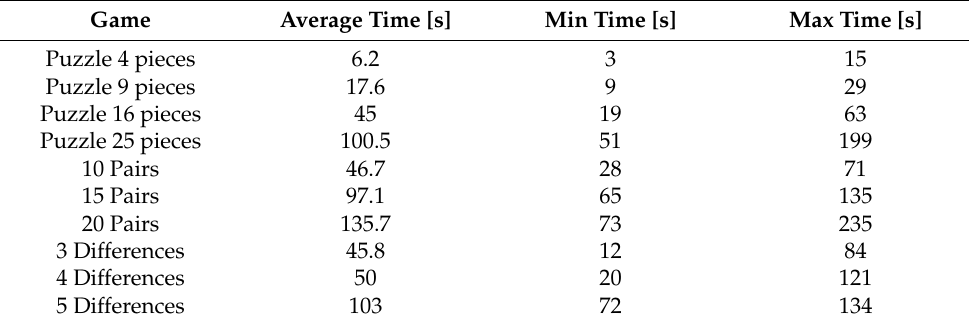
Table 2. Experimental results for level completion times of the